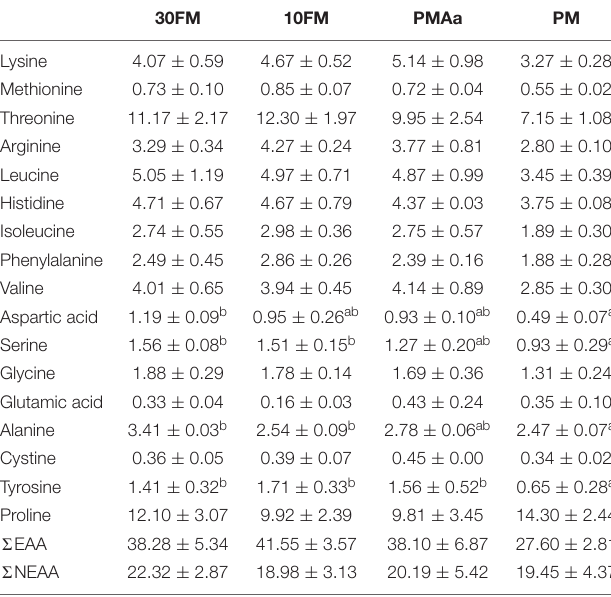
Values are mean of three replicates ± SEM (standard error). Means in the same row with different superscripts are significantly different (p < 0.05). (cid:54) EAA: The sum of essential amino acids (Lys, Met, Thr, Arg, Leu, His, Ile, Phe, and Val). (cid:54) NEAA: The sum of non-essential amino acids (Asp, Ser, Glu, Ala, Cys, Gly, Tyr, and